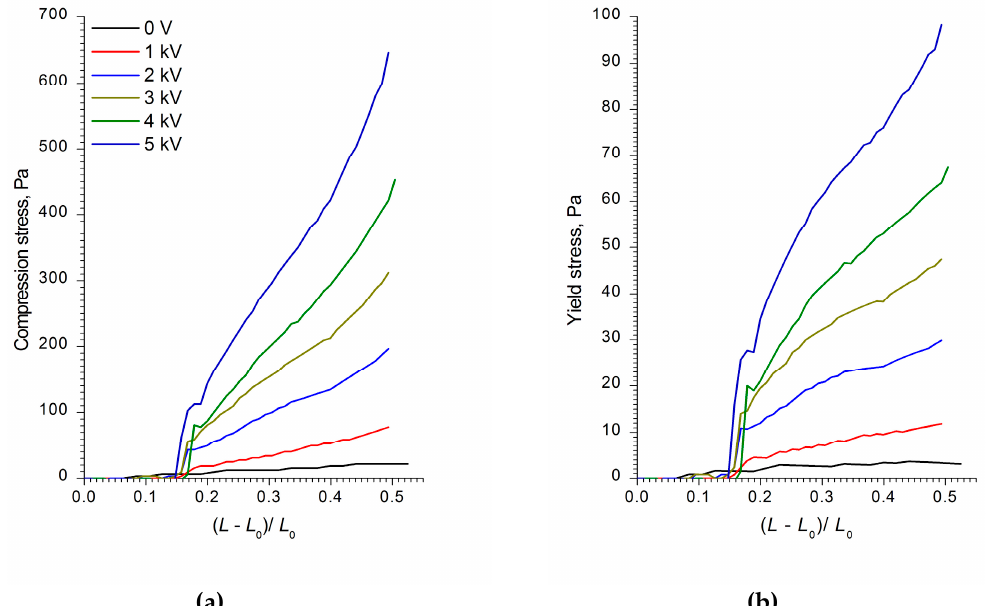
(cid:4666)(cid:3013)(cid:2879)(cid:3013) (cid:3116) (cid:4667) at various values of voltage applied. (cid:3013) (cid:3116) ( L − L 0 ) L 0